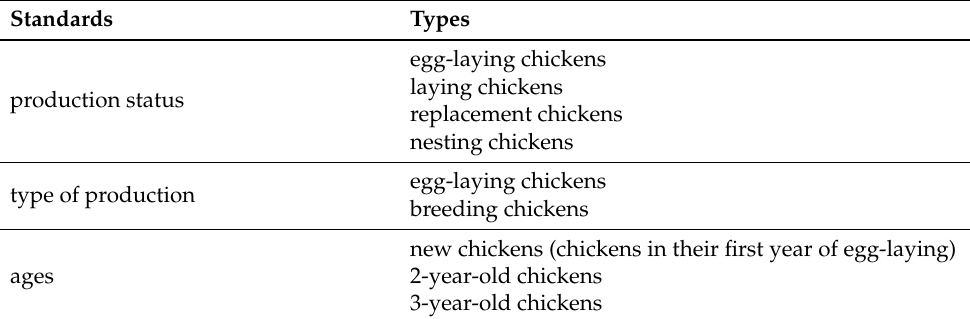
Table 1. The information about chickens in diverse classification